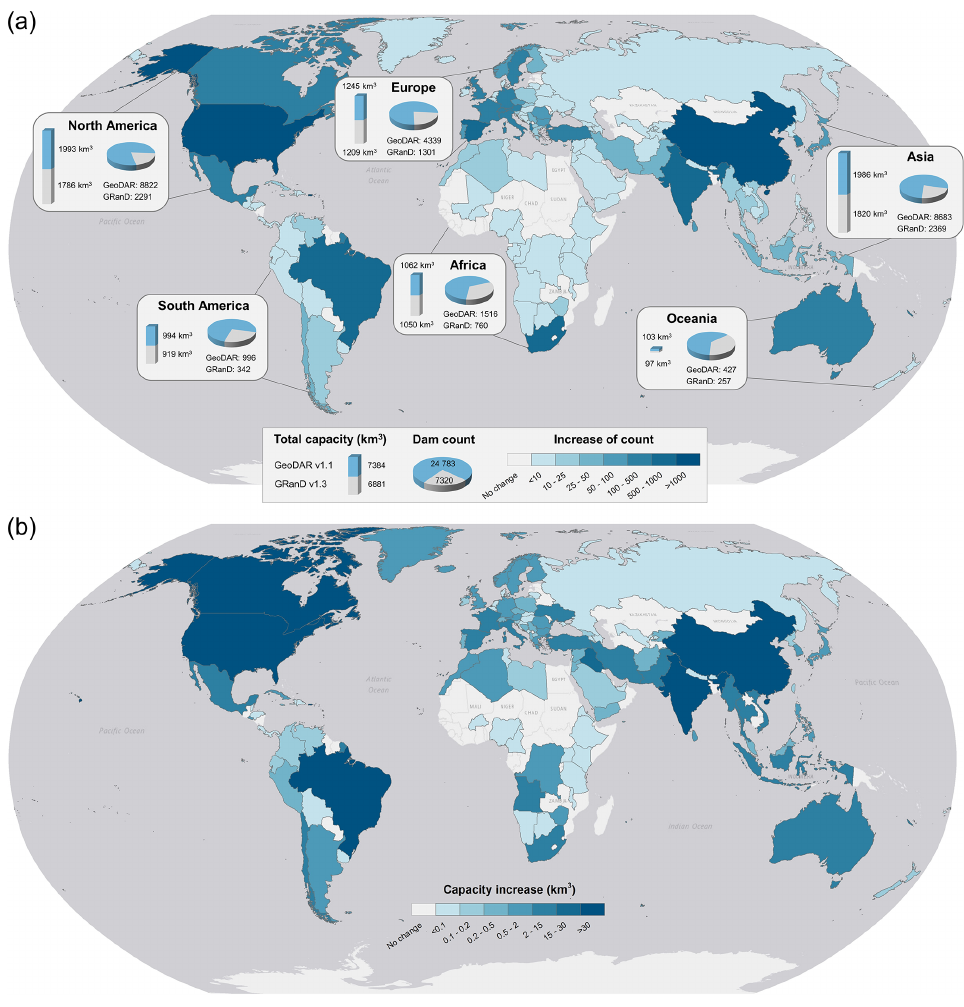
Figure 14. Country-level improvements in GeoDAR v1.1 over GRanD v1.3. (a) Increase in dam count and (b) increase in total reservoir storage capacity for each country or territory. Aggregated statistics for dam count and storage capacity were also compared for each continent. For convenience of comparison, both statistics are displayed in panel (a)